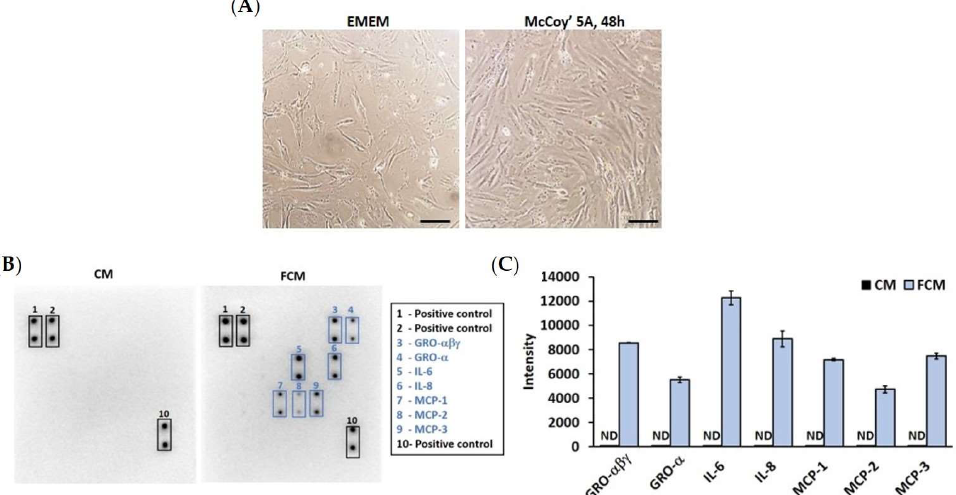
Figure 1. High proliferative colon fibroblast releases pro-inflammatory cytokine in FCM. ( A ) Colon fibroblast (CCD-18co) cultured in Eagle-minimum essential media (EMEM) for approximately 80% confluence. Then, the fibroblast was changed to Mccoy’5A media for 48 h culture. The fibroblast represented approximately 95–100% confluence (magnification 100×). ( B ) Cytokine array was performed to detect the cytokine content in FCM which incubated the active colon fibroblast for 48 h. ( C ) The intensity of pro-inflammatory cytokine of CM and FCM. CM = complete media (control), FCM = fibroblast-cultured media, ND = not